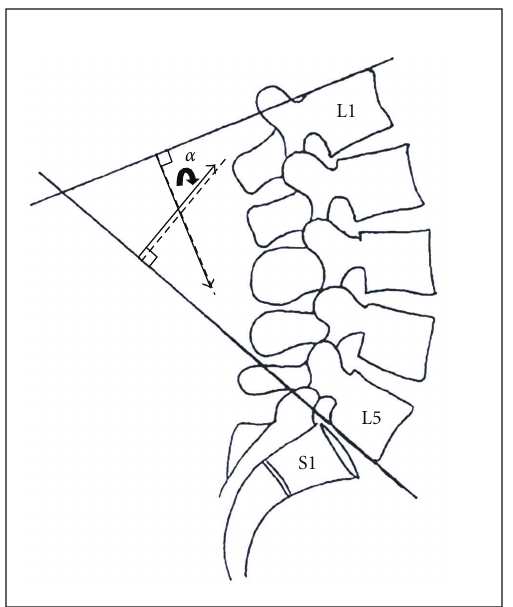
Figure 1: Measurement of lumbar lordotic angle α . Using Cobb’s method, tangent lines are drawn along the superior end pated of L1 and S1. Perpendiculars to each of the lines are added to form α .